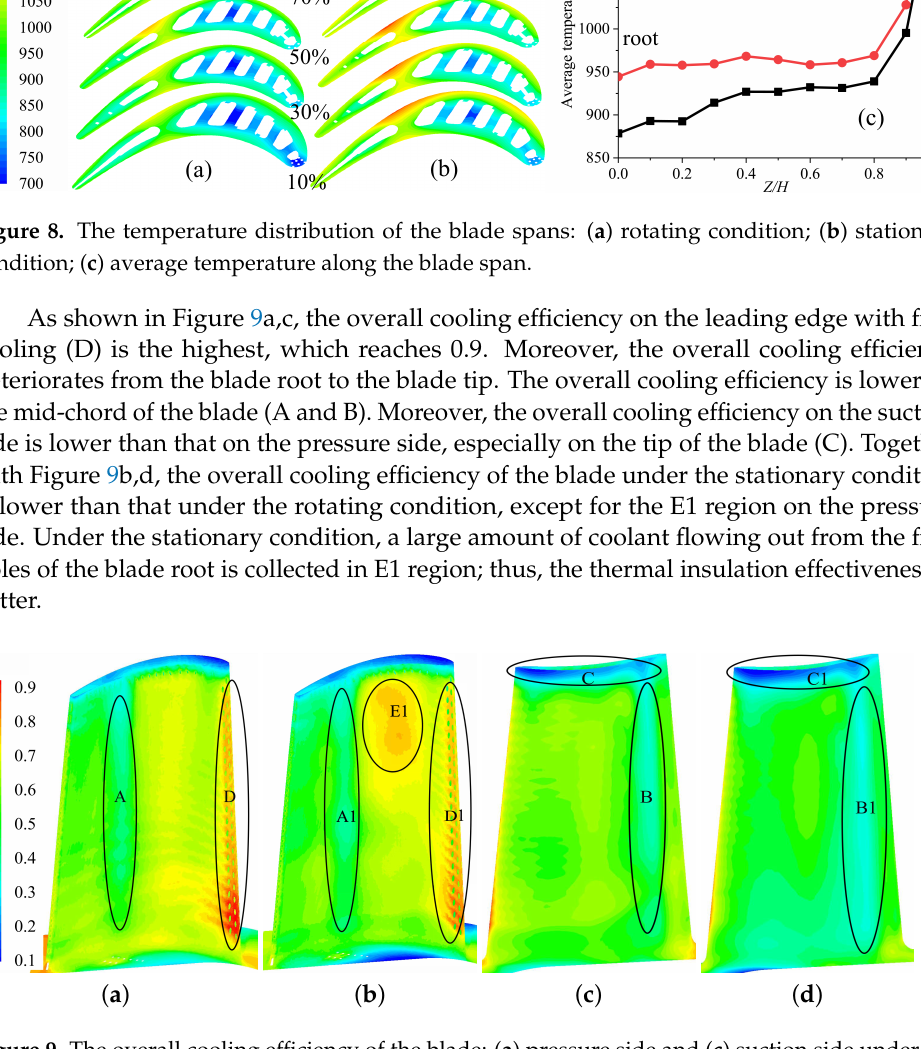
Figure 9. The overall cooling efficiency of the blade: ( a ) pressure side and ( c ) suction side under the rotating condition; ( b ) pressure side and ( d ) suction side under the stationary condition (A(A1)–C(C1) represent low–heat transfer areas; D(D1) and E(E1) represent high–heat transfer